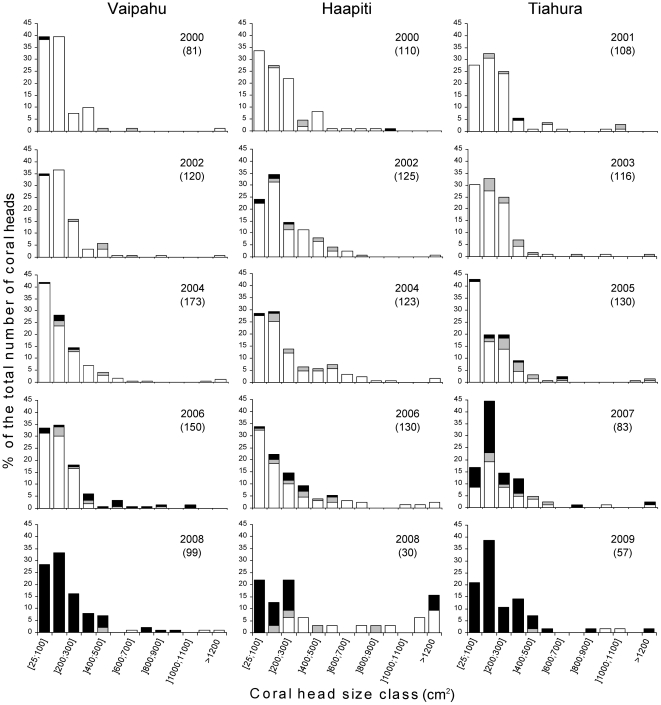
Effects of a recent outbreak of Acanthaster planci from 2006–2009 on Pocillopora populations.Size-class (cm2) distributions of live (white), partially dead (grey) and completely dead (black) corals (Pocillopora spp.) as a proportion of the total number of coral heads at each site. High resolution photographs of 60 permanent quadrats were taken at three sites in Moorea (20 quadrats/site) every two years from 2000 to 2008 at the sites Vaipahu and Haapiti and from 2001–2009 at Tiahura. Numbers in parentheses represent the total number of Pocillopora measured per site.